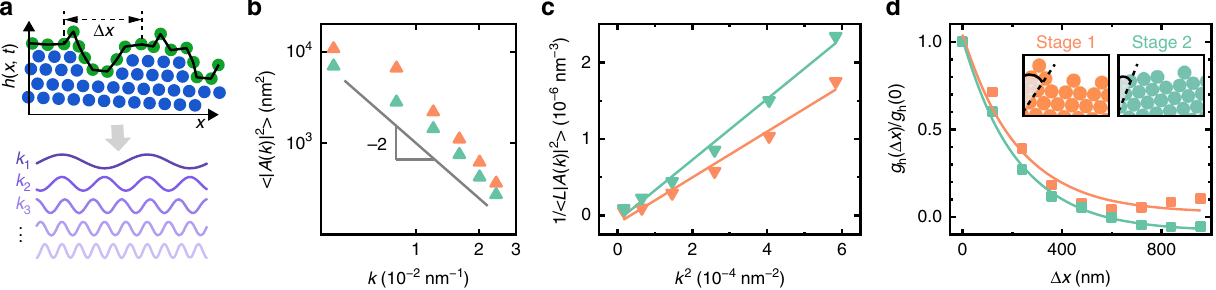
Fig. 4 Validation of capillary wave theory (CWT) at the nanoscale and calculation of orientation-dependent interfacial stiffness. a Schematic illustrating the Fourier decomposition of the height function h ( x , t ) into superimposed waves with different wave vectors ( k 1 , k 2 , k 3 , … ). b Dependence of hj A ð k Þj 2 i on k on a log-log scale plot for stage 1 (salmon) and stage 2 (aquamarine). The gray line of a power law of − 2 is drawn to guide the eye. c Dependences of 1 = L hj A ð k Þj 2 i on k 2 overlaid with the corresponding linear fi tting lines for the two stages. d Plot of lateral correlation functions g h ( Δ x ) normalized by g h (0) as a function of Δ x (de fi ned in a ) overlaid with exponential fi tting for stage 1 (salmon) and stage 2 (aquamarine). Insets highlight the different surface orientations of two